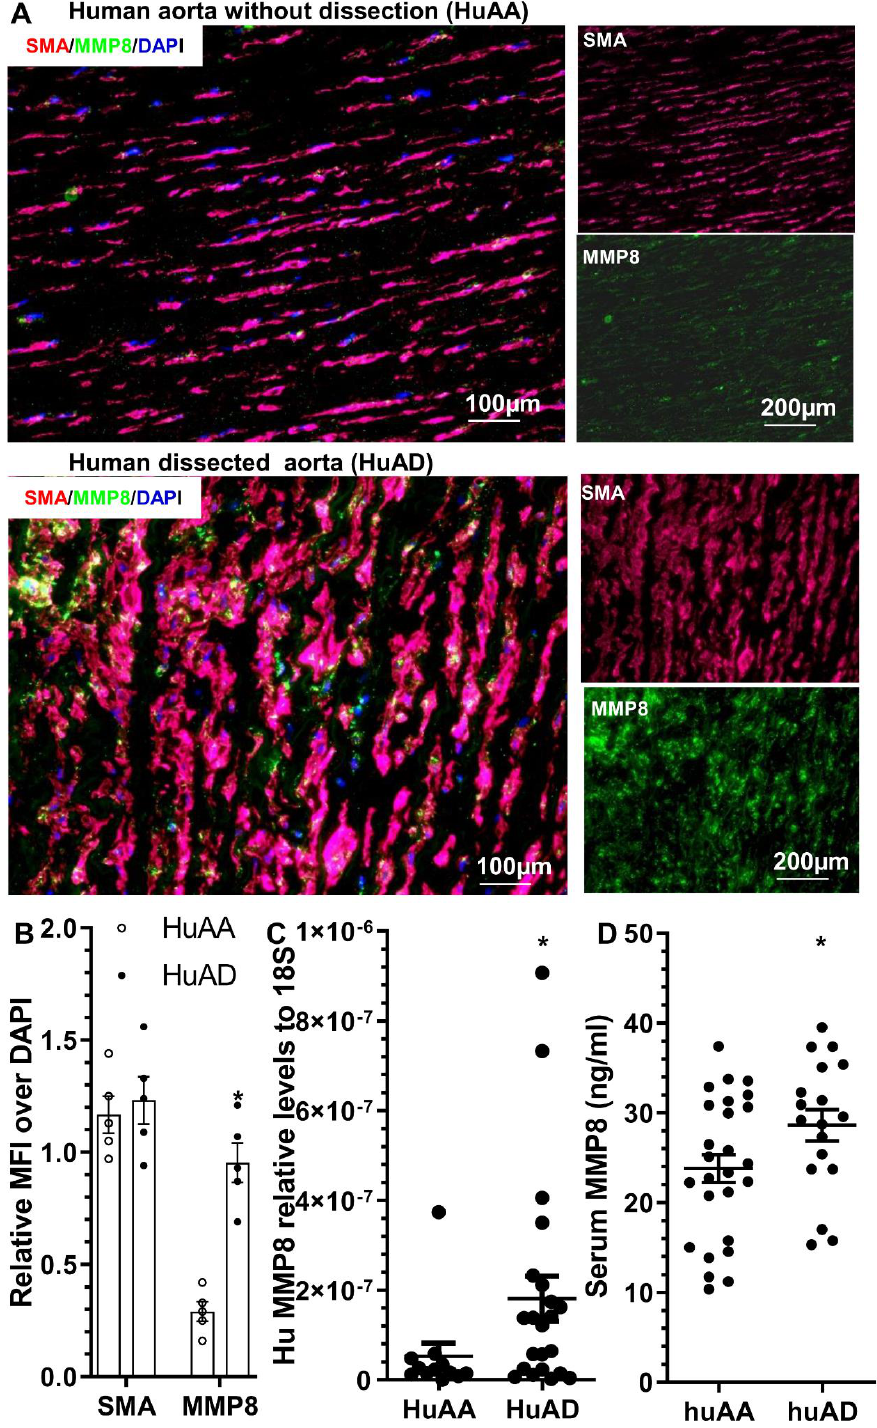
Figure 7. MMP8 detection in human ascending aorta with (HuAD) or without (HuAA) dissection. ( A , B ) Immunofluorescent staining showed increased expression levels of MMP8 protein in a dissected human ascending aorta. Representative images ( A ) and relative mean fluorescence intensity (MFI) ( B ) of MMP8 or SMA over DAPI staining are presented here. * p < 0.05 ( n = 5, versus HuAA) (unpaired t -test). ( C ) RT-qPCR analysis showed increased MMP8 gene expression in a human ascending aorta with dissection. * p < 0.05 ( n = 12 for HuAA or 22 for HuAD, versus HuAA) (Mann–Whitney U test). ( D ) ELISA analysis showed increased serum MMP8 levels in patients with acute TAD. * p < 0.05 (versus HuAA, n = 26 for HuAA and 18 for HuAD) (Mann–Whitney U